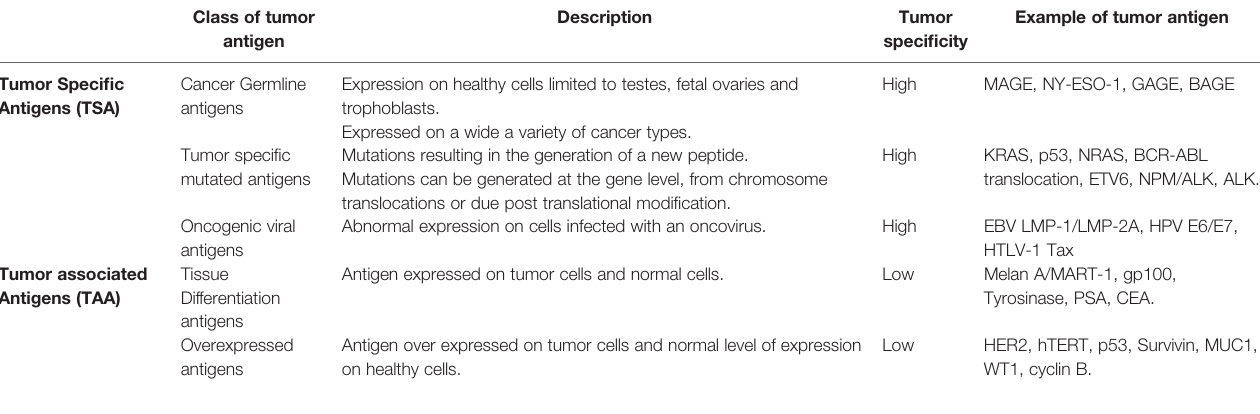
TABLE 1 | Different types of tumor